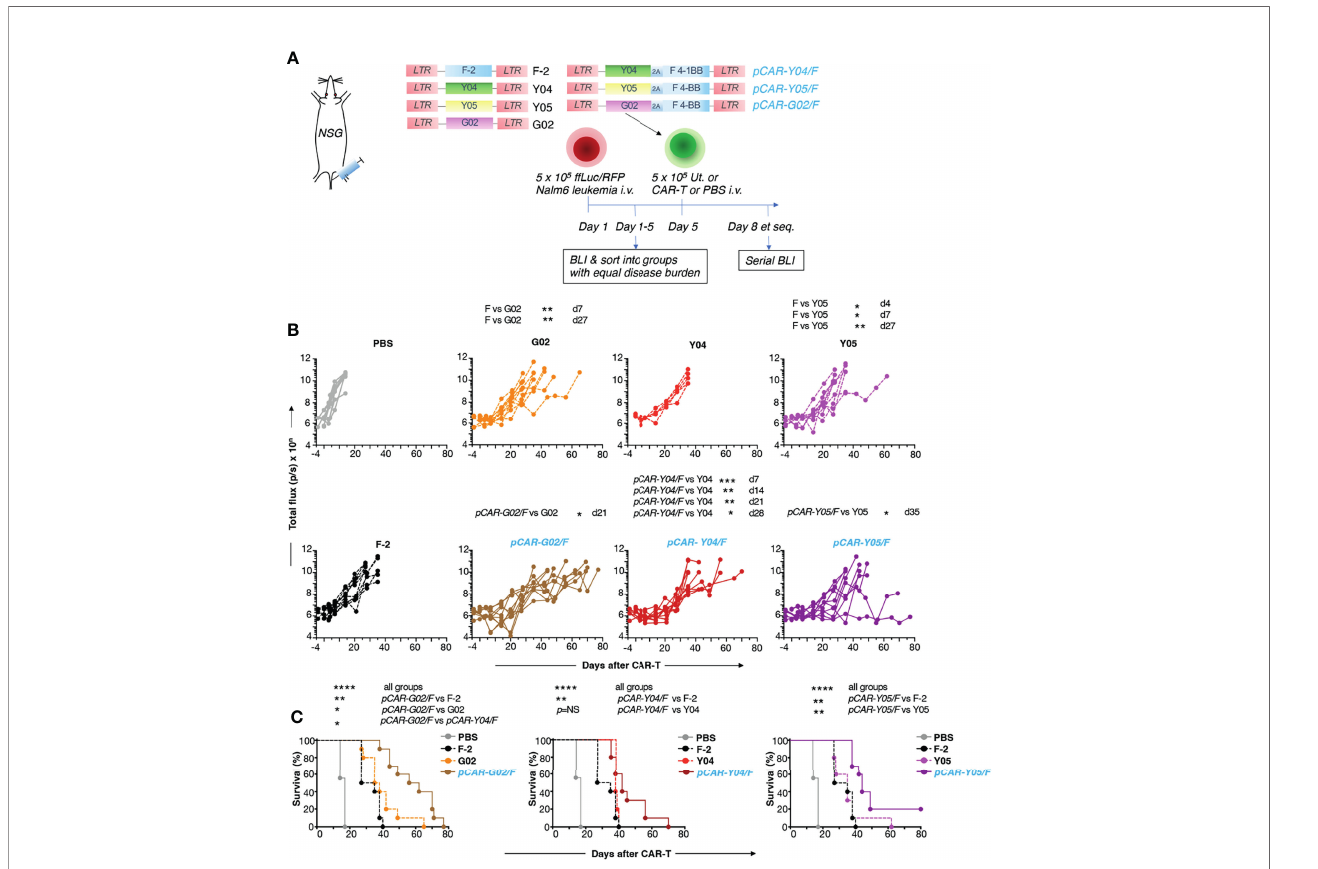
FIGURE 7 | In vivo evaluation of pCARs targeted against CD19. (A) NSG mice (n=5-10 per group) were inoculated i.v. with 5 x 10 5 ffLuc/RFP + Nalm-6 cells. On day 5, mice with established leukemia were treated i.v. with 5 x 10 5 CAR or pCAR T-cells or PBS. (B) Tumor burden in individual mice following treatment was monitored by BLI. Data are pooled from 2 donors. Statistical analysis was performed using an unpaired Student t test comparing the indicated CARs/pCARs. (C) Survival curves of mice. Statistical analysis was performed using a Log-rank (Mantel-Cox) test, comparing the indicated groups. * p < 0.05; ** p < 0.01; *** p < 0.001; **** p <